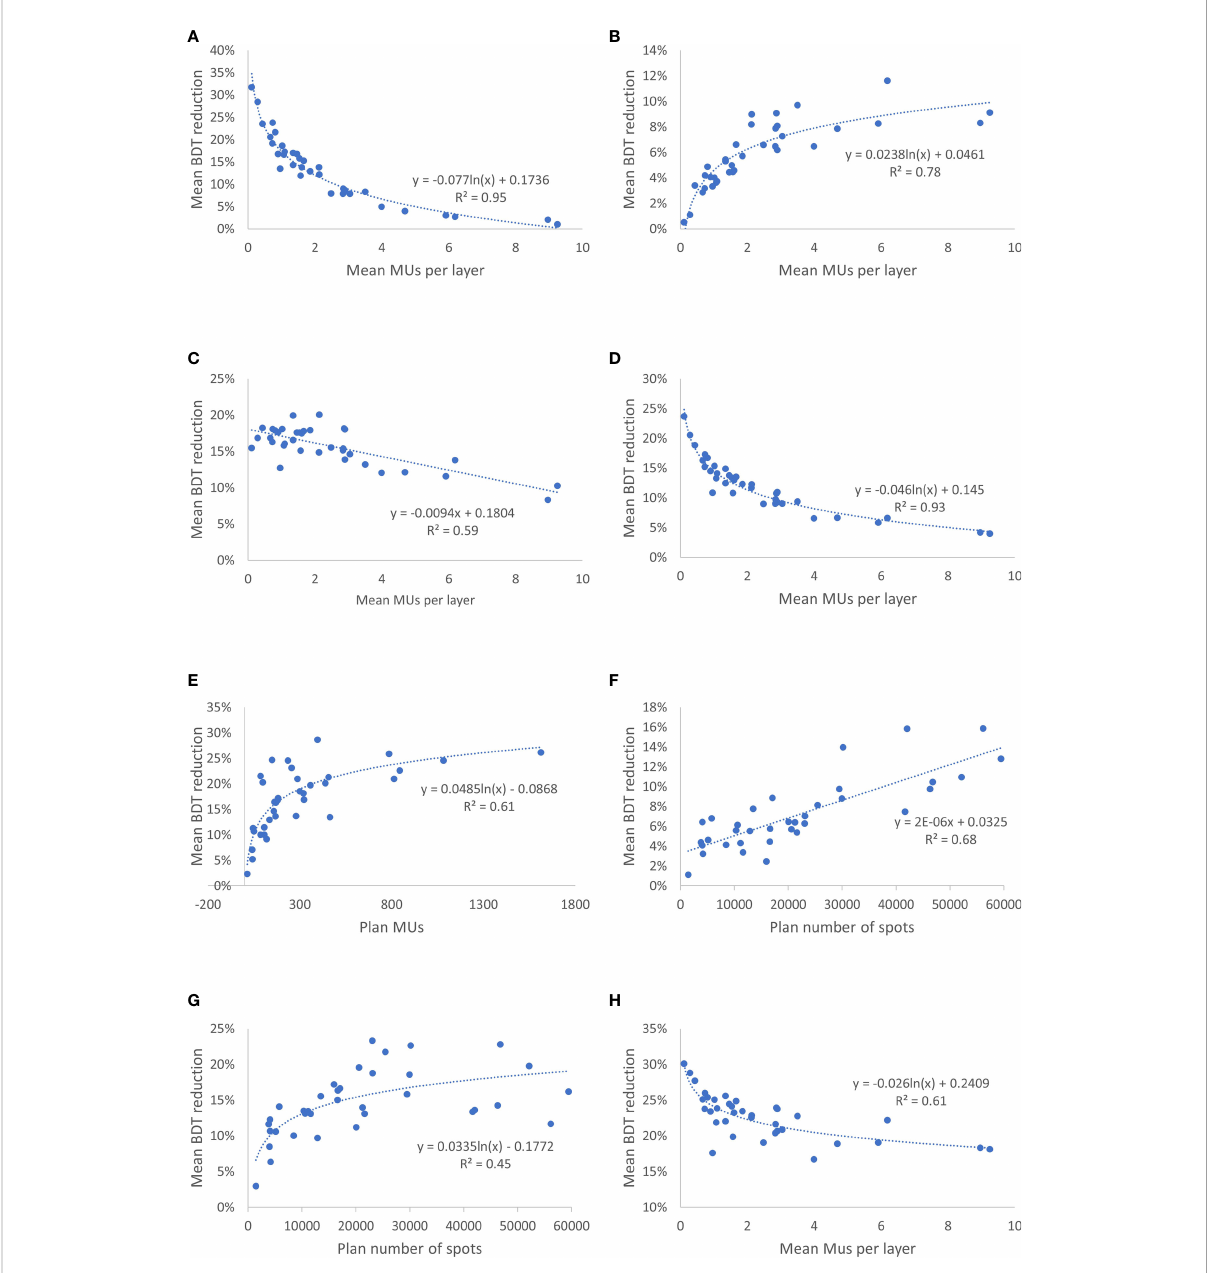
FIGURE 3 Correlation Between Mean Reduction in Beam Delivery Time (BDT) From Improved Operating Parameters and Treatment Plan Characteristics. (A) Mean reduction in BDT from increasing the number of multiple energy extraction (MEE) layers per spill from 4 to 8 as a function of the treatment plan mean number of monitor units (MUs) per layer. (B) Mean reduction in BDT by increasing the number of monitor unit (MU) per spill from 20 to 30 as a function of the treatment plan mean number of MUs per layer. (C) Mean reduction in BDT by increasing the recapture ef fi ciency from 50% to 80% as a function of the treatment plan mean number of MUs per layer. (D) Mean reduction in BDT by reducing the layer switch time from 200 to 100 msec as a function of the treatment plan mean number of MUs per layer. (E) Mean reduction in BDT by increasing the beam intensity from 8 to 20 MU/s as a function of the treatment plan number of MUs. (F) Mean reduction in BDT by increasing the scanning magnet scan speed from [6,10] to [8,20] m/s in the [x,y] direction as a function of the treatment plan spot number. (G) Mean reduction in BDT by reducing the scanning magnet preparation and veri fi cation time from 1.9 msec to 0.95 msec as a function of the treatment plan spot number. (H) Mean reduction in BDT by reducing the spill change time from 2 seconds to 1 second as a function of the treatment plan mean number of MUs per